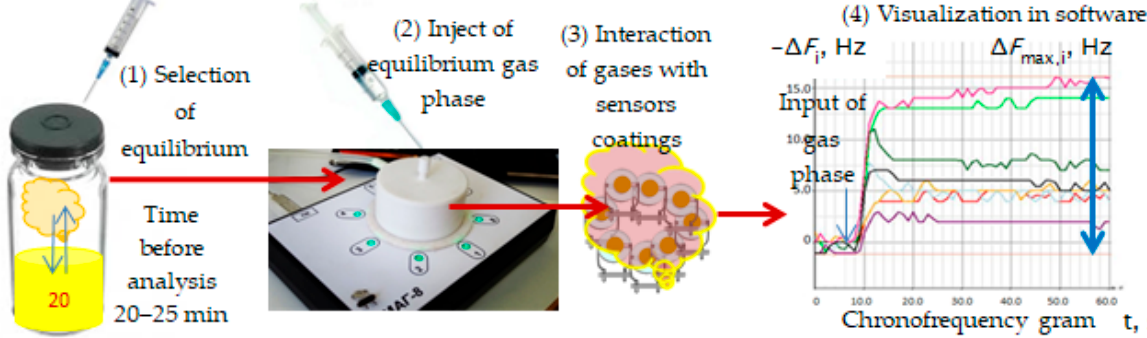
Figure 2. Process of measurement of gas phase of urine sample using sensor array.